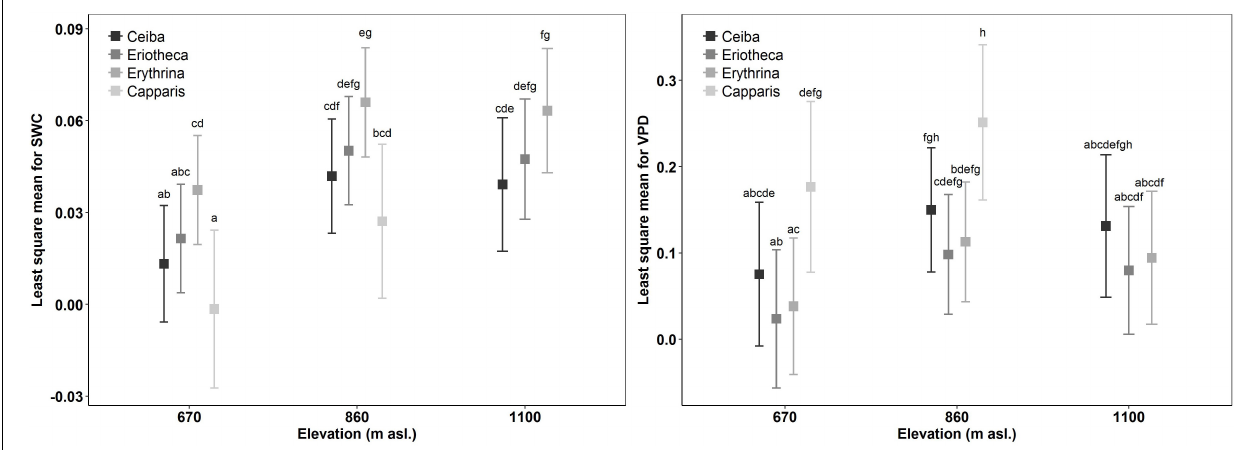
FIGURE 3 | Comparison of sap flux density response to SWC and VPD for species over elevation to measure sap flux sensitivity in accordance with environmental drivers. Boxes indicate least-squares means; error bars indicate 95% confidence interval of the least square means. Means sharing a letter are not significantly different (Tukey-adjusted